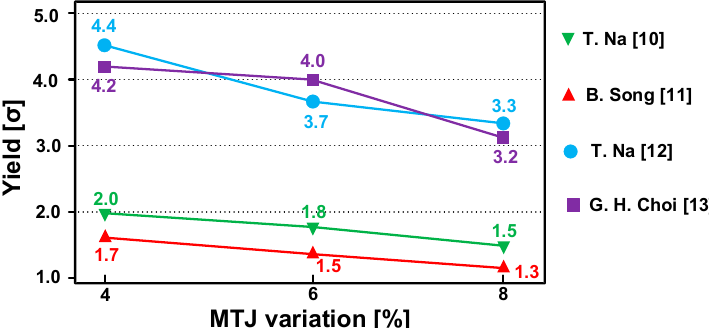
Figure 5. Restore yield of four state-of-the-art NVFFs [10–13] relative to the MTJ variation at SS corner. For this simulation, V DD of 0.6 V is used.